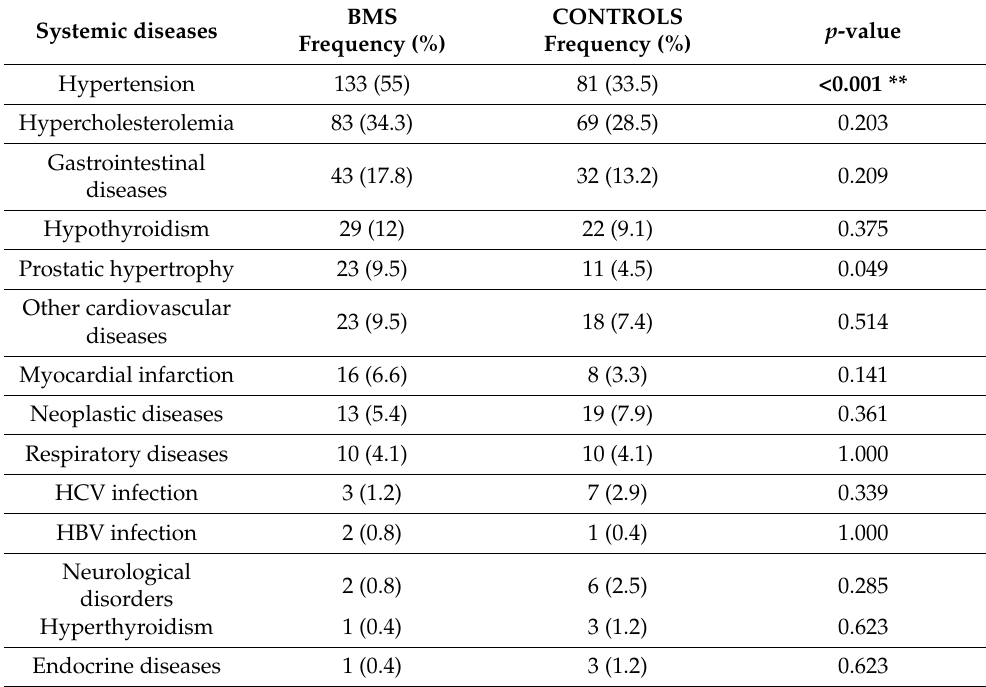
Table 2. Evaluation of the prevalence of systemic diseases, drug consumption and antihypertensive drugs in 242 BMS patients and 242